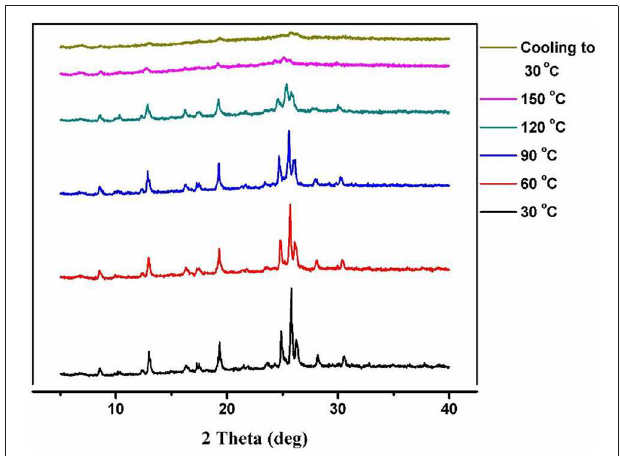
FIGURE 3 | Variable temperature PXRD patterns of compound 1 .